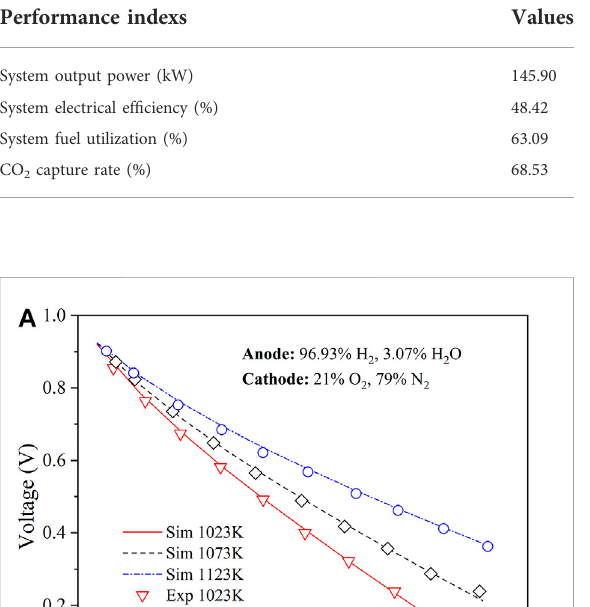
TABLE 3 The IGFC hybrid system performance.